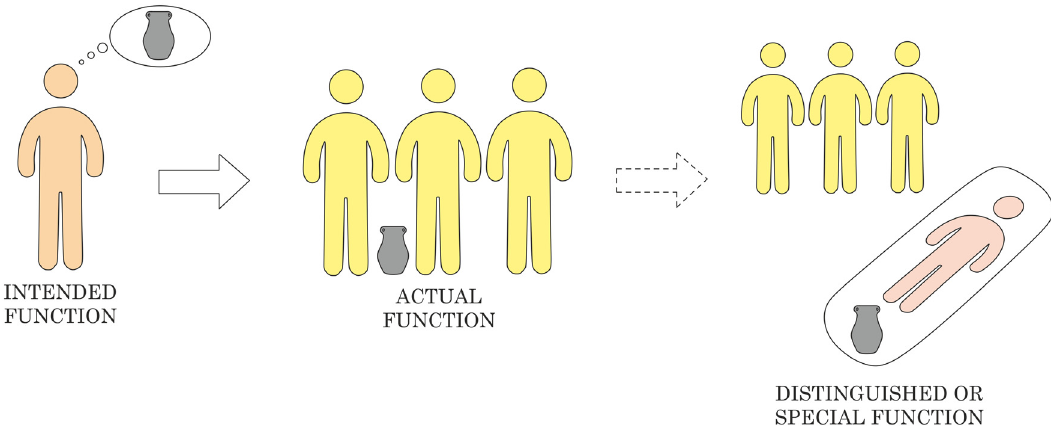
Figure 1: The intended, actual, and distinguished or special function of the